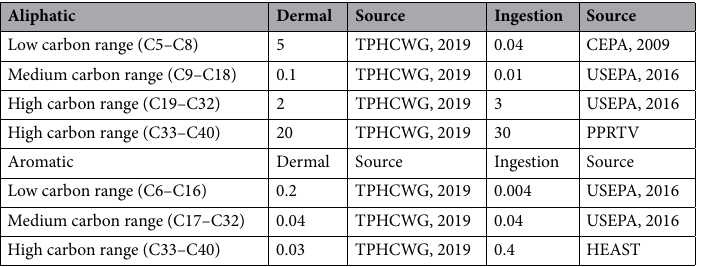
Table 2. Reference dose of total petroleum hydrocarbons (TPHs). TPHCWG Total Petroleum Hydrocarbon Criteria Working Group, PPRTV Provisional Peer-Reviewed Toxicity Value, HEAST Health Effect Assessment Summary